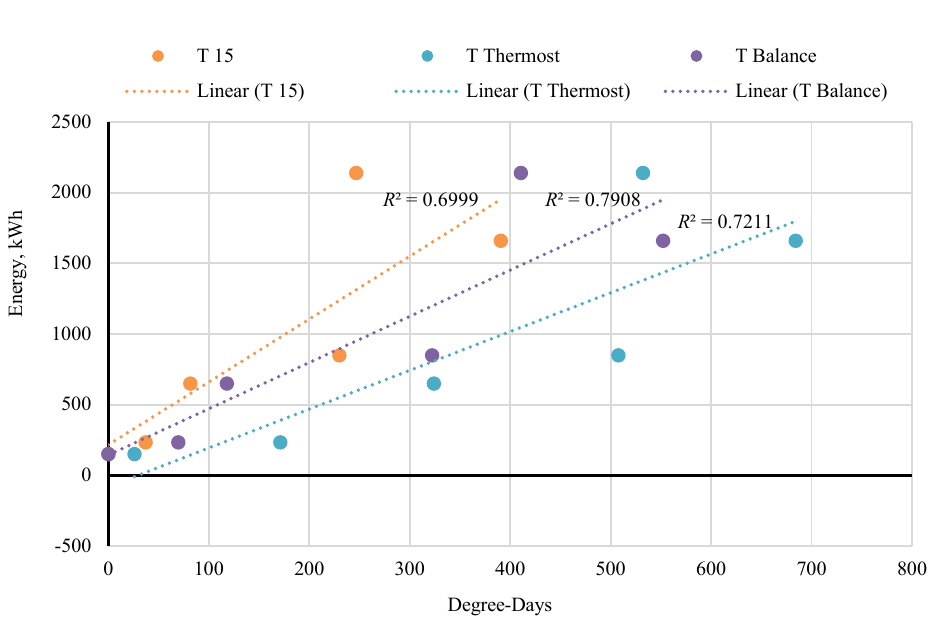
Fig. 2. Energy consumption versus degree-days for building